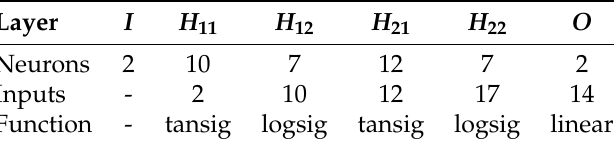
Table 1. The internal composition of the proposed nested neural networks